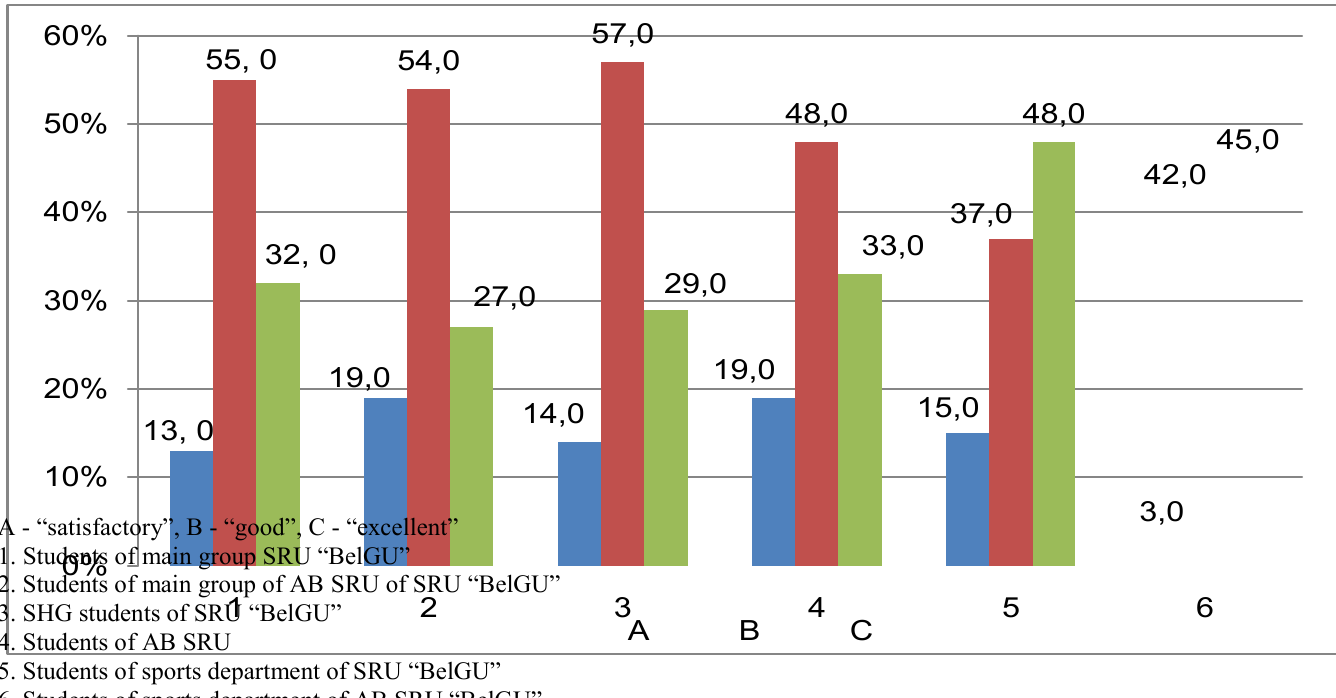
Fig.6. Students progress of different groups, living and studying in urban environment (BSNRU,) and in the country of (AB BSNRU,)